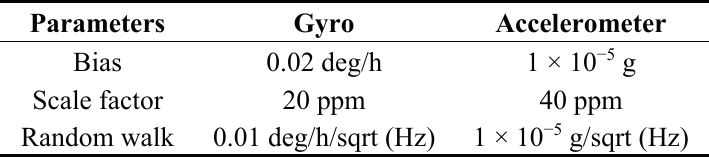
Table 4. Navigation grade IMU technical data.